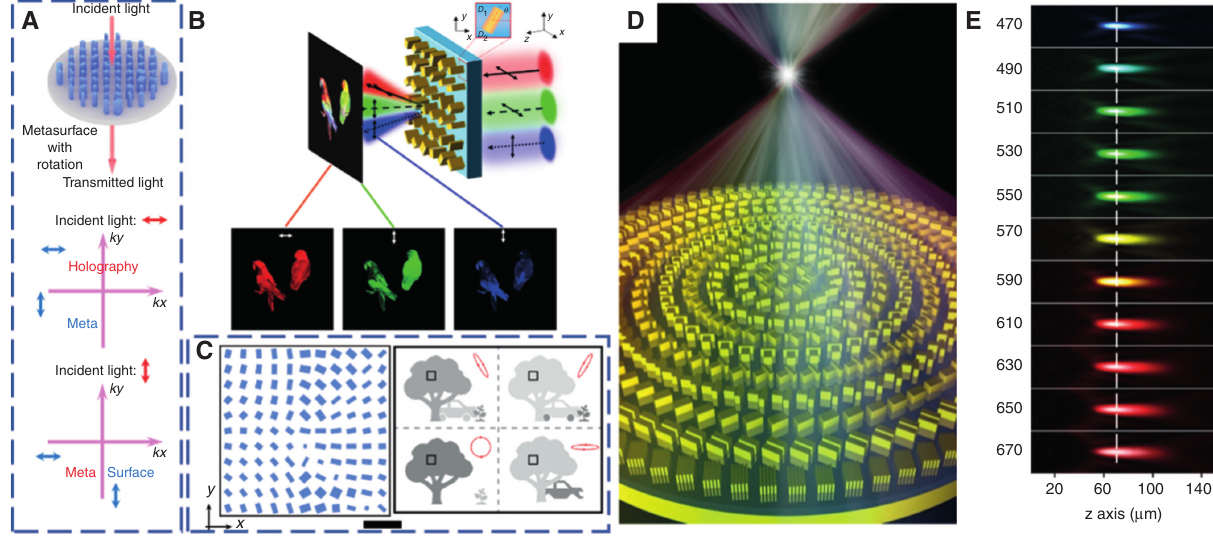
Figure 19: Nanostructures with three design degrees of freedom for phase manipulation in multiple polarization modes. (A) Multichannel metaholography [138]. (B) Color metaholography [139]. (C) Polarization camera [140]. (D and E) Achromatic metalenses in IR and visible light ranges, respectively [141, 142]. Reprint permission obtained from [138–142].